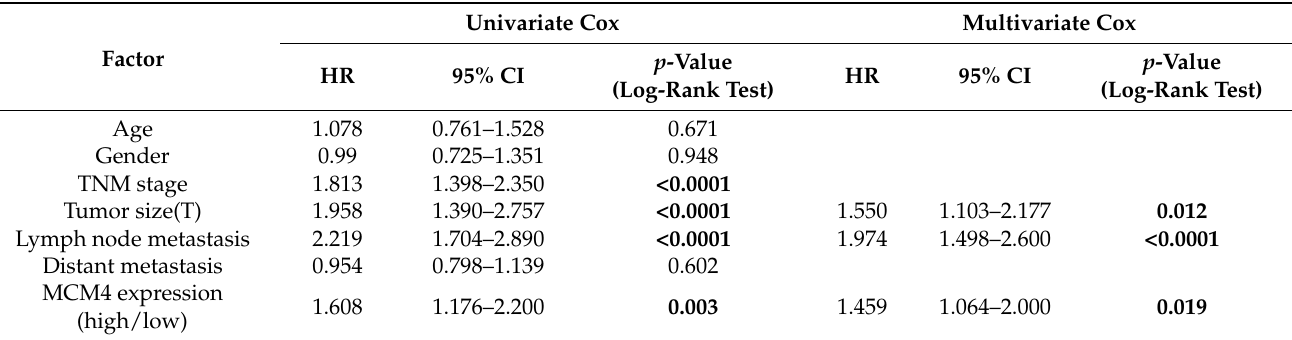
Table 3. Univariate and Multivariate analyses (Cox regression model) of MCM4 in LUAD